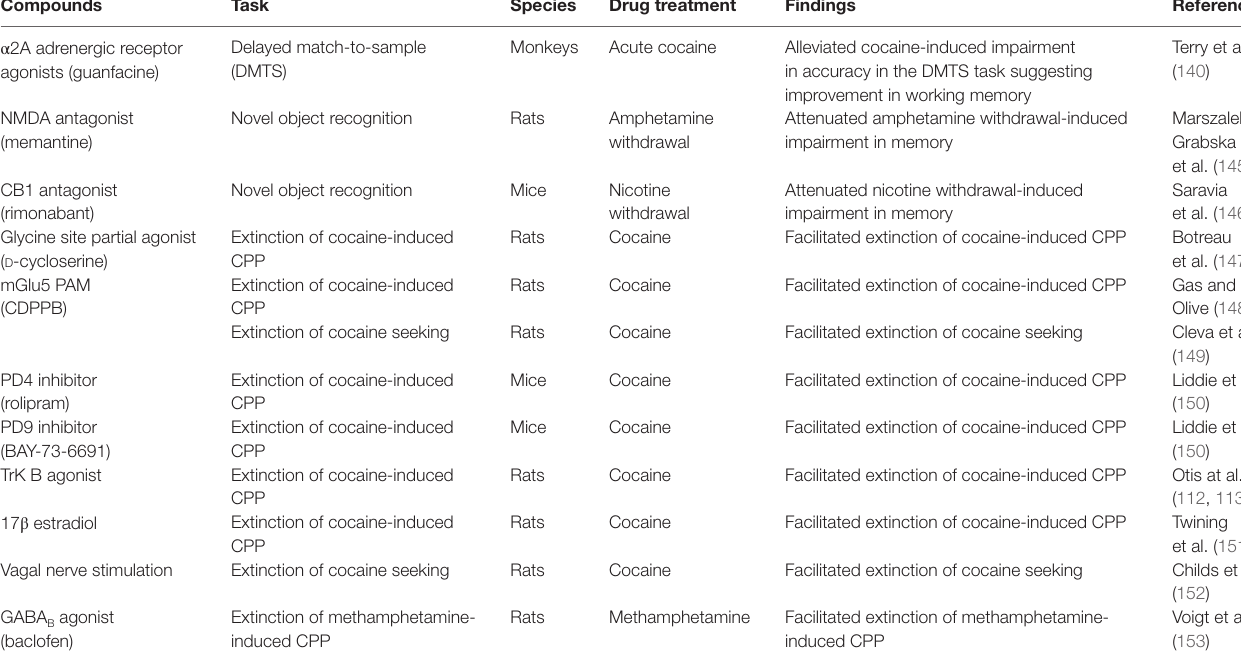
TABLE 3 | Pharmacological alleviation of psychostimulant-induced memory impairment and/or facilitation of extinction learning.